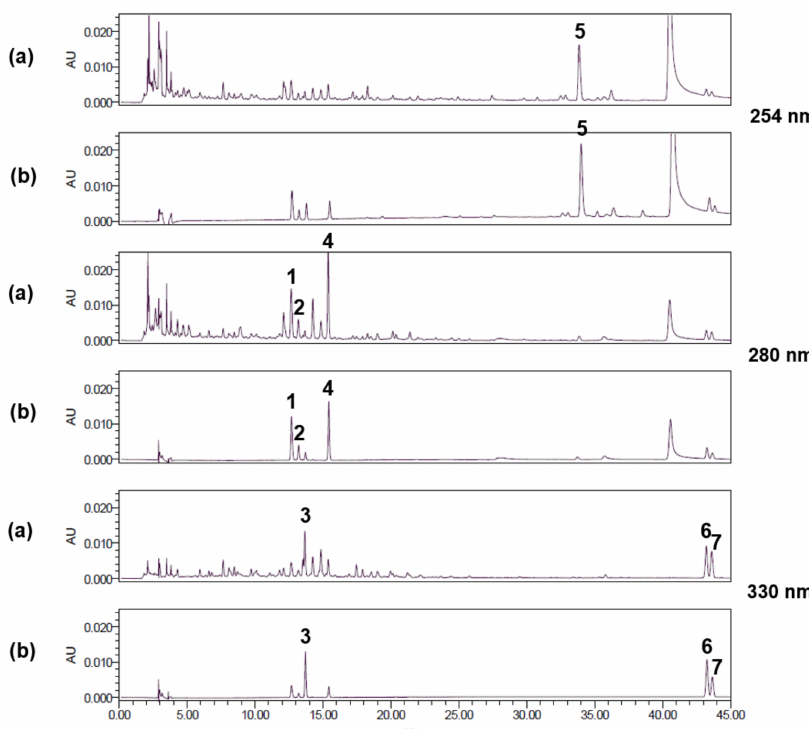
Figure 5. High-performance liquid chromatography (HPLC) chromatograms of BJIGT components ( a ) and a standard mixture ( b ) at 254 nm, 280 nm, and 330 nm. Components included: Liquiritin apioside ( 1 ), liquiritin ( 2 ), nodakenin ( 3 ), hesperidin ( 4 ), glycyrrhizin ( 5) , decursin ( 6 ), decursinol angelate ( 7 ).